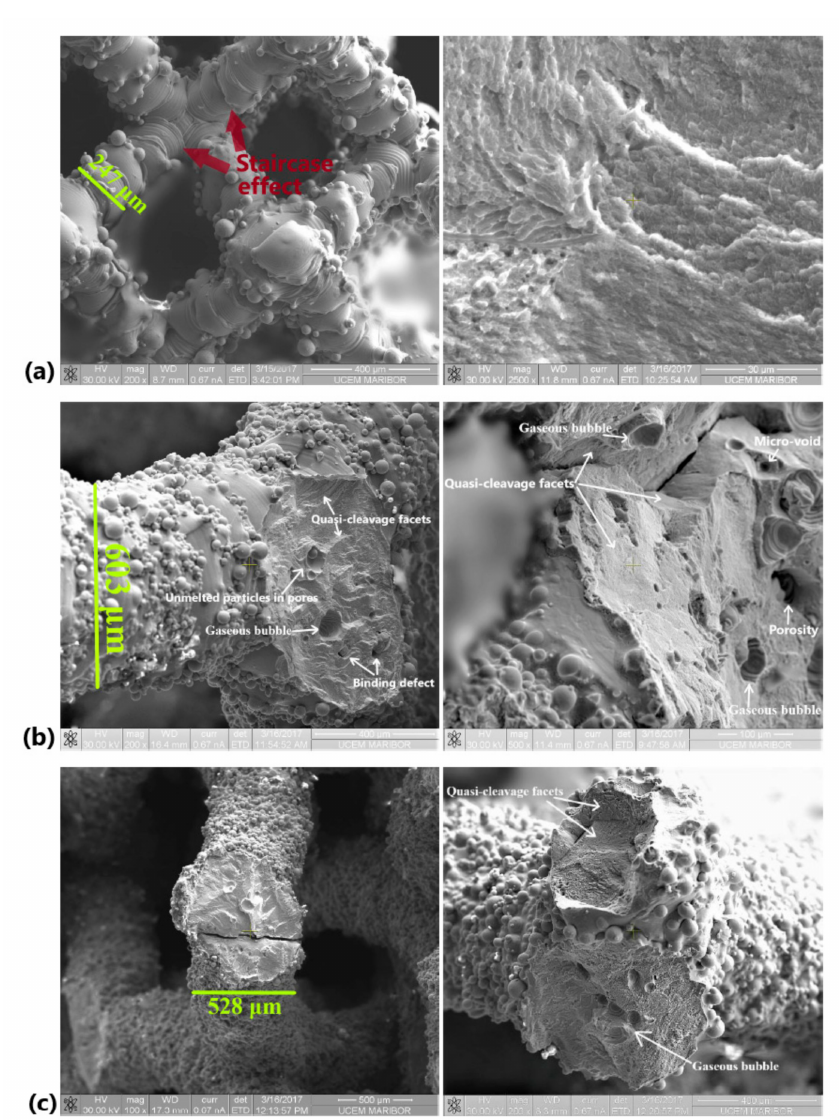
Figure 5. SEM analysis of strut fracture obtained after compression test: ( a ) BCC, ( b ) PCI, and ( c ) PHS. The white arrows indicate some fracture